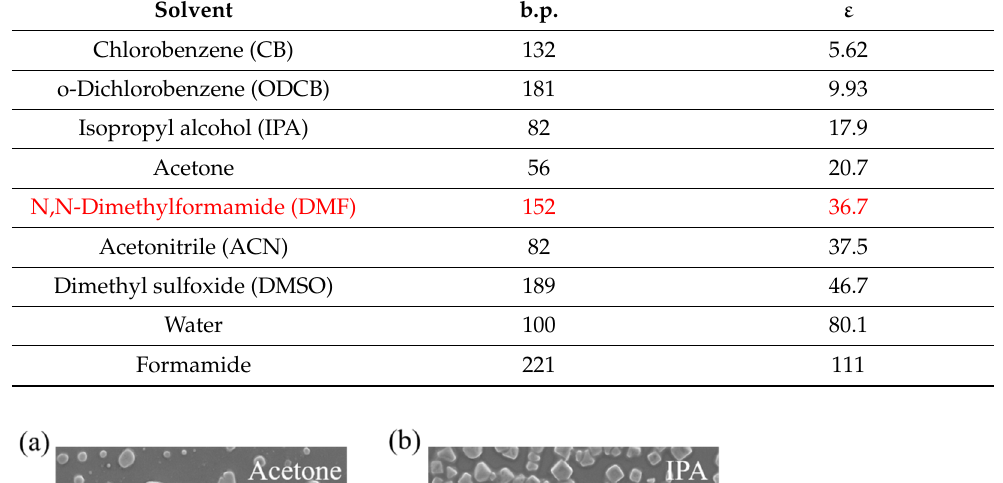
Table 1. Dielectric constant ( ε ) and boiling point (b.p.) of the commonly used solvents.